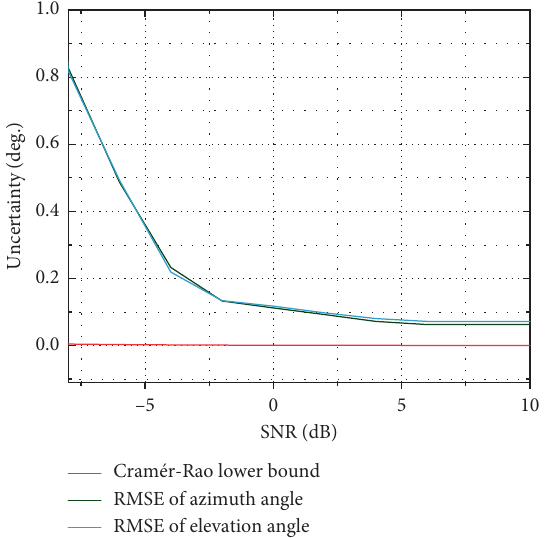
Figure 12: Comparison of DOA estimation RMSE and